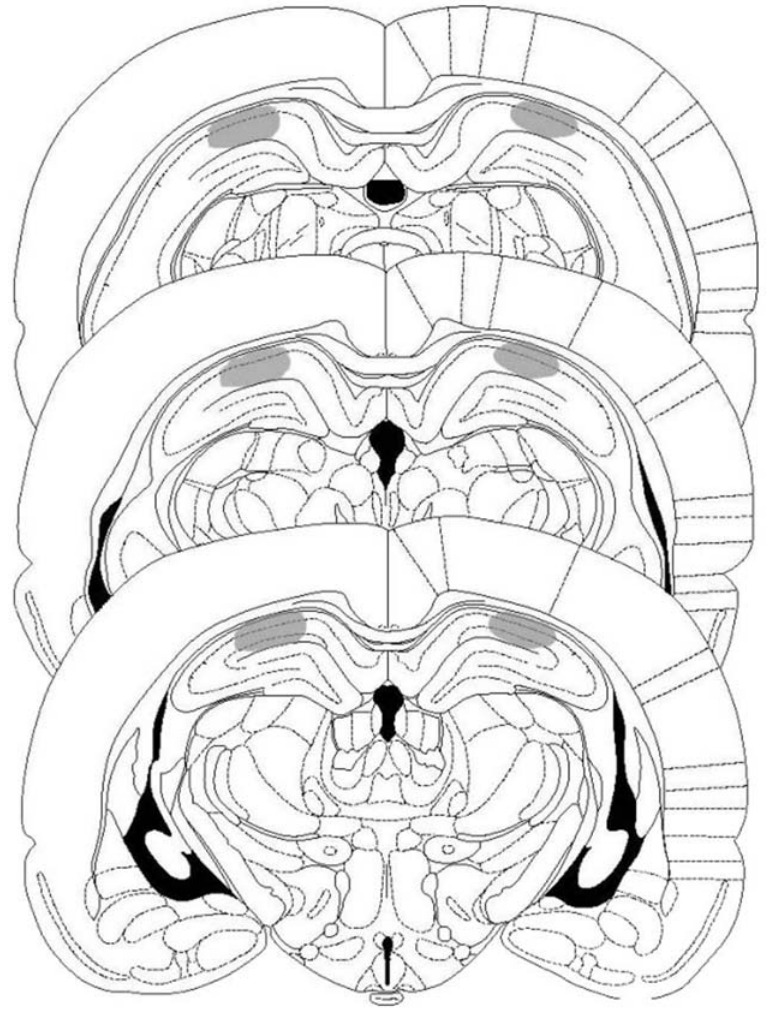
Figure 2. Cannulae Placements and Drug Infusions. Schematic representations of rat brain sections at three rostrocaudal planes ( 2 3.80, 2 4.30, and 2 4.80 from bregma) taken from the atlas of Paxinos and Watson, showing, in stippling, the extension of the area reached by the infusions in the dorsal hippocampus. Reprinted from The Rat Brain in Stereotaxic Coordinates by Paxinos and Watson, pages 33, 35, and 37, Academic Press (1997), with permission from Elsevier.